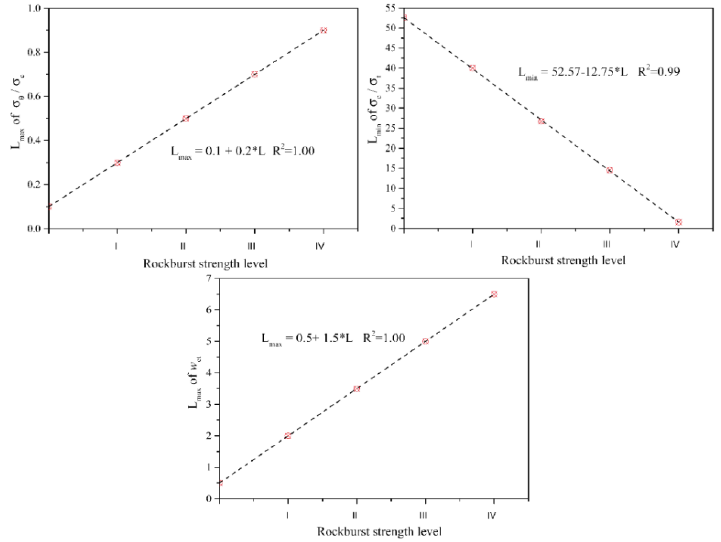
Figure9. Polynomialregressionofthequantitativeboundaryeigenvalue ( L min or L max ) Figure 9. Polynomial regression of the quantitative boundary eigenvalue (𝐿 𝑚𝑖𝑛 𝑜𝑟 𝐿 𝑚𝑎𝑥 ) for all indicators.